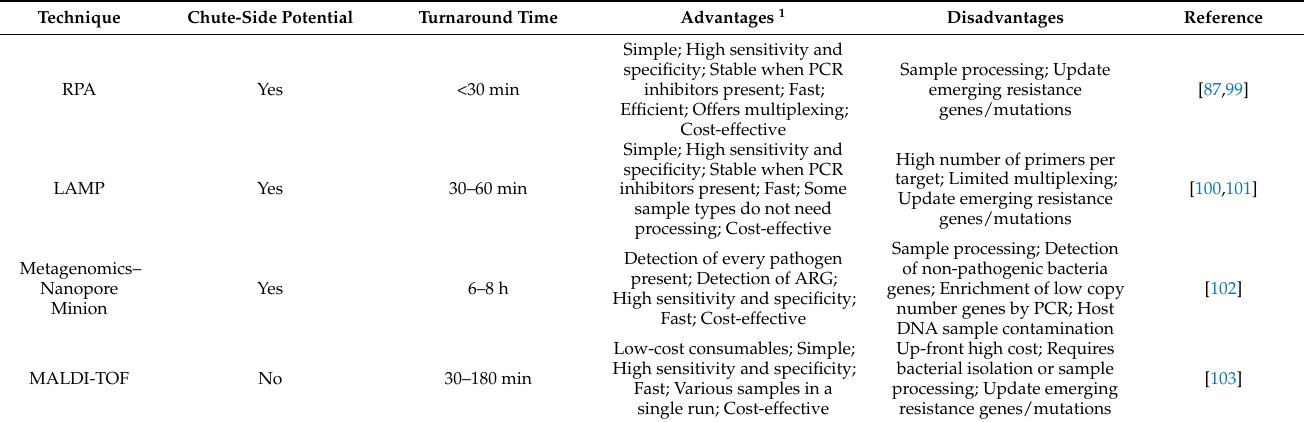
Table 6. Approaches for the rapid detection of antimicrobial-resistant